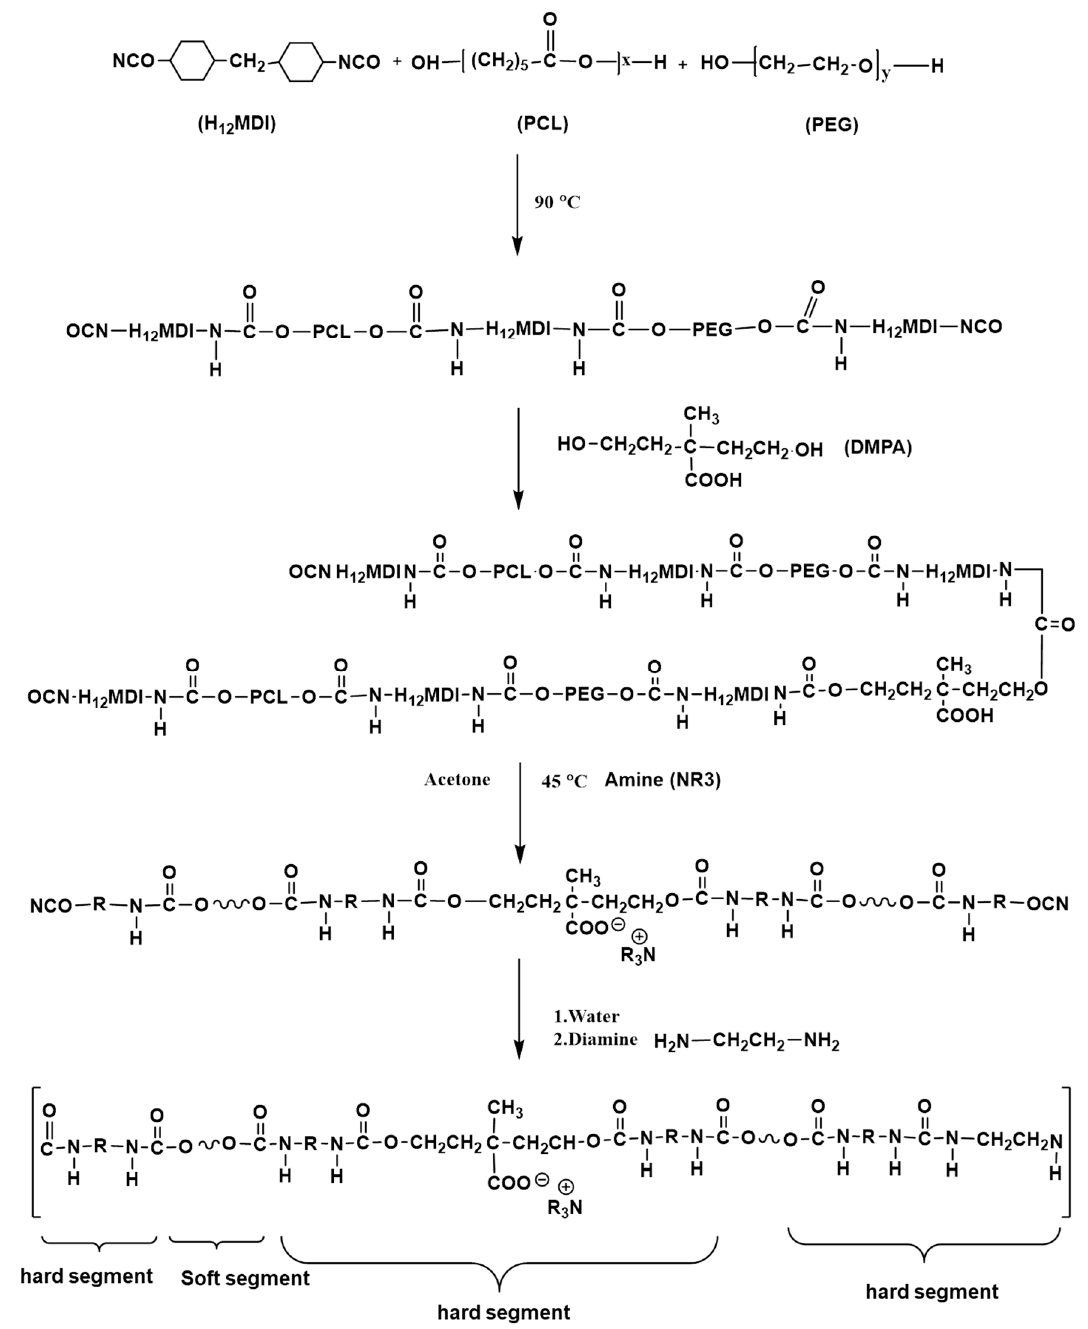
Figure 1. The synthesis process of a waterborne polyurethane (WPU).